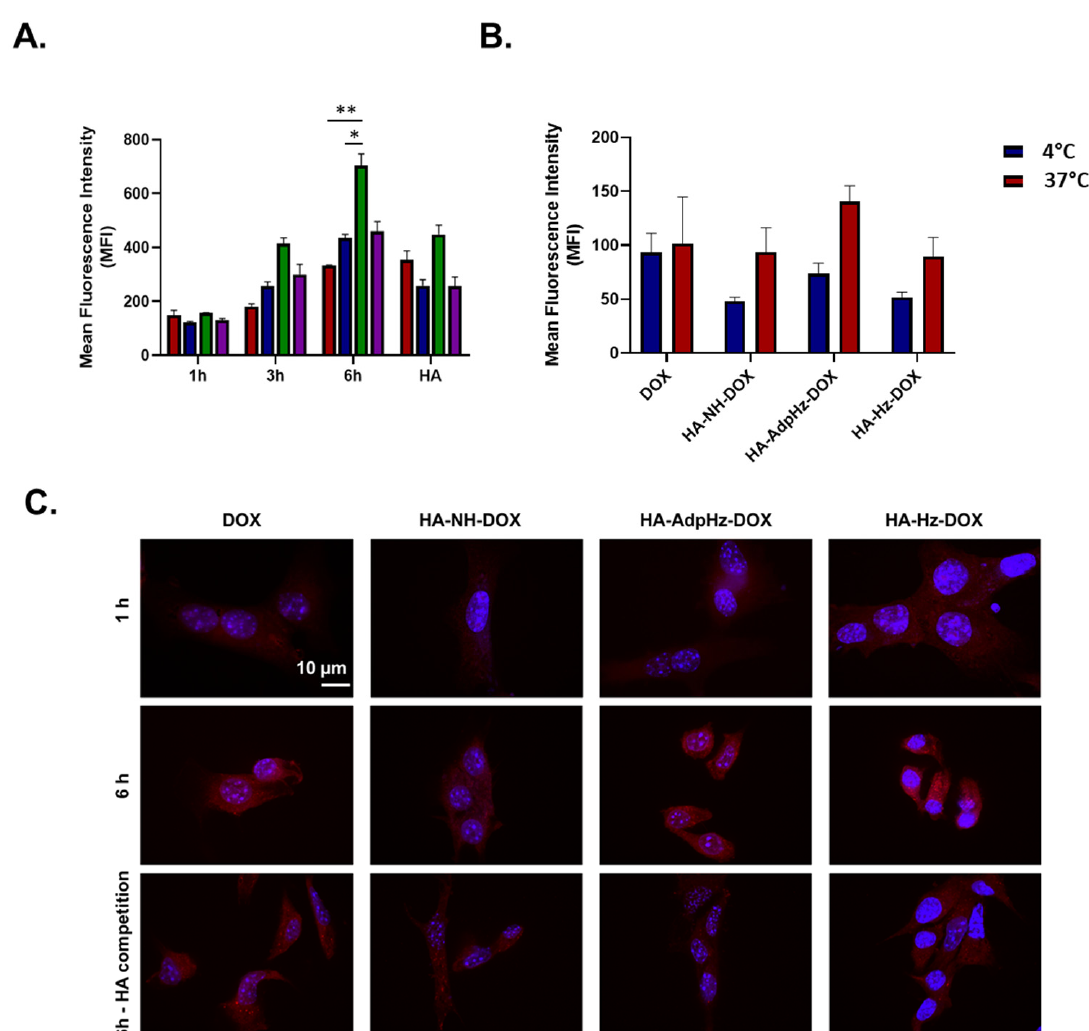
Figure 3. GL261 cell uptake of DOX and HA-DOX conjugates. ( A ) Cell uptake of DOX equivalent concentration of free DOX, HA-NH-DOX, HA-AdpHz-DOX, and HA-Hz-DOX conjugates (1 μ M in DOX equivalent concentration) at 1, 3, and 6 h by FACS analysis. HA competition assay was as- sessed by pre-incubating the cells with free HA (5 μ M) (Mean, error bar = SD, N = 3). ( B ) FACS analysis on GL261 cell uptake at 4°C and 37 °C. ( C ) Representative confocal microscopy images of GL261 cell uptake of DOX equivalent concentration of free DOX, HA-NH-DOX, HA-AdpHz-DOX, and HA-Hz-DOX conjugates (1 μ M in DOX equivalent concentration) at 1 and 6 h. HA competition assay was assessed by pre-incubating the cells with free HA (5 μ M). Nuclei were stained with DAPI (DAPI: blue; DOX: red). Data were processed through GraphPad (Mean, error bar = SD, N = 3, sta- tistical analysis obtained by one-way ANOVA multiple comparison: ns = not significant, * p < 0.05, ** p < 0.01). Free DOX: red; HA: yellow; HA-NH-DOX: blue, HA-AdpHz-DOX: violet; HA-Hz-DOX: green.